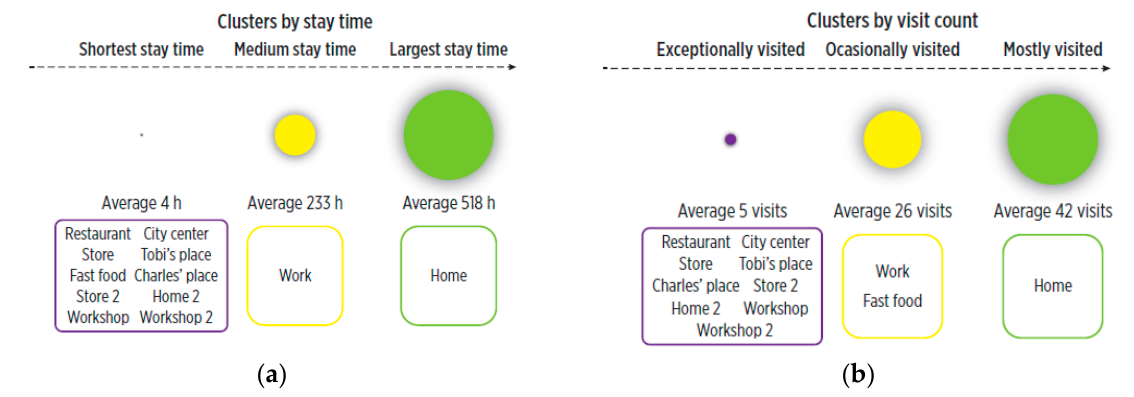
Figure 7. Categorization of the POIs according to temporal features: ( a ) stay time, ( b ) visit count.